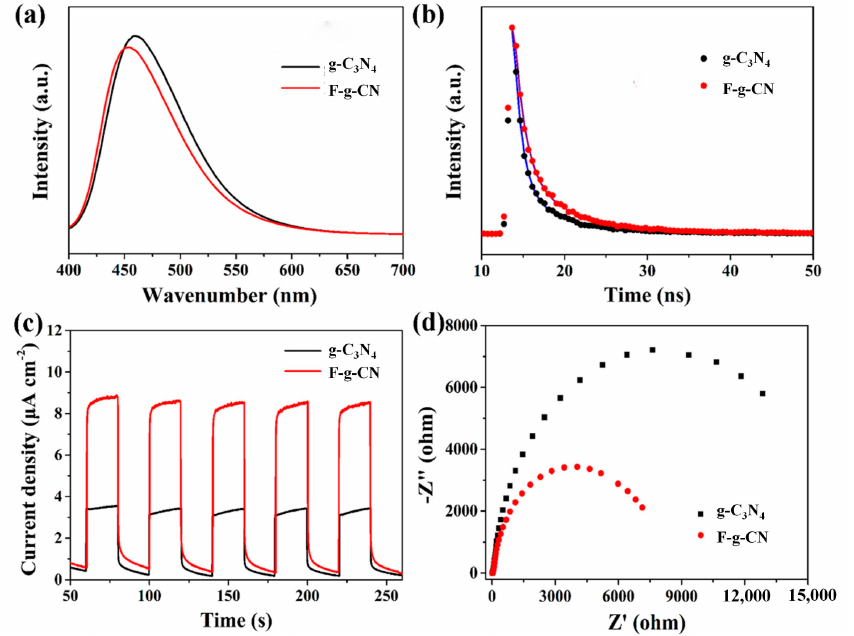
Figure 6. ( a ) PL spectra and ( b ) time-resolved PL spectra of g-C 3 N 4 and F-g-CN. ( c ) Transient photocurrent responses and ( d ) EIS plots of g-C 3 N 4 and